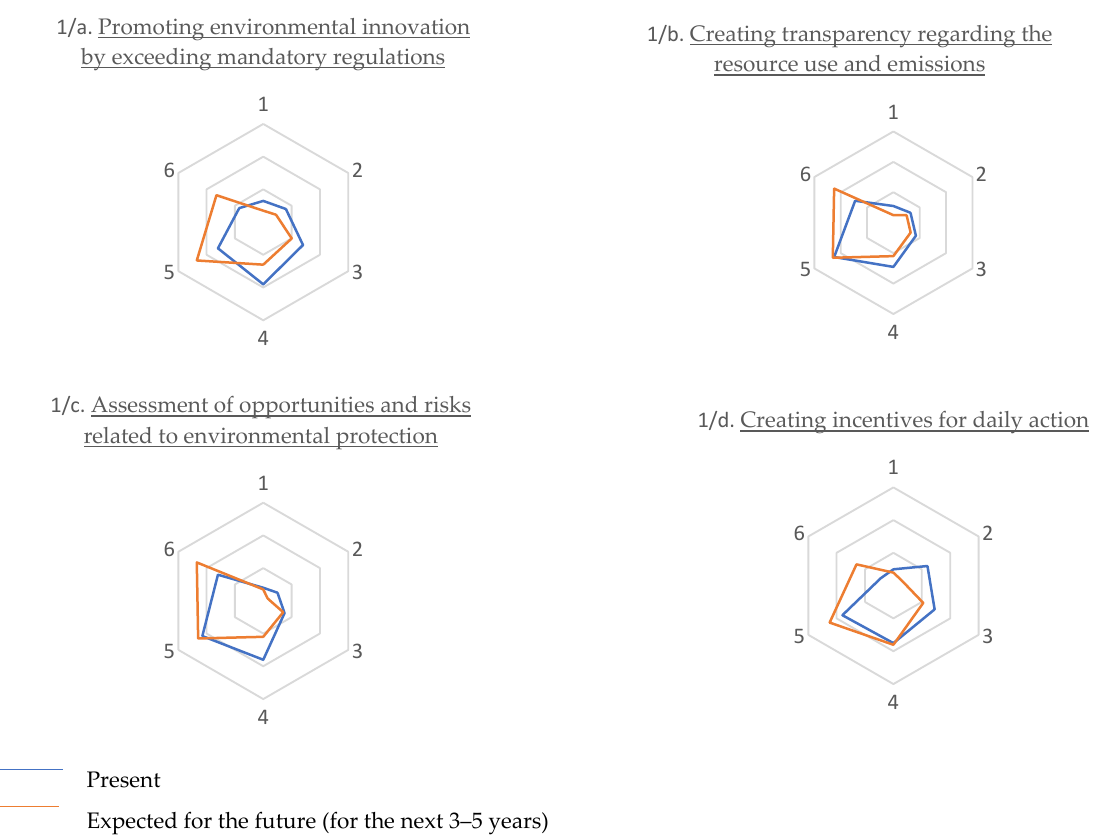
Figure 4. The spider web diagram of the scores given by the respondents at Stage 1 of becoming sustainable. Source: edited by authors.